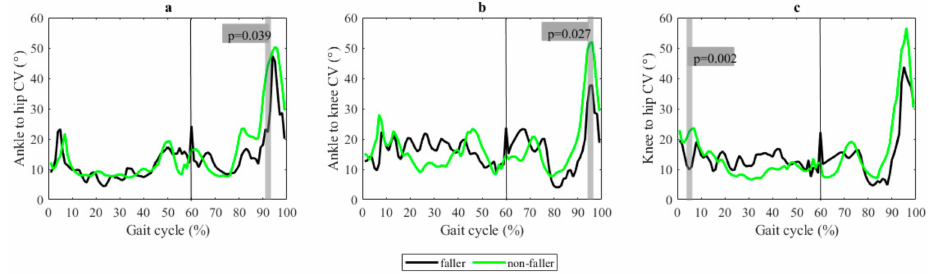
Figure 4. ( a ) Ankle-to-hip coordination variability (CoordV), ( b ) ankle-to-knee CoordV, and ( c ) knee-to-hip CoordV during gait cycles in fallers and